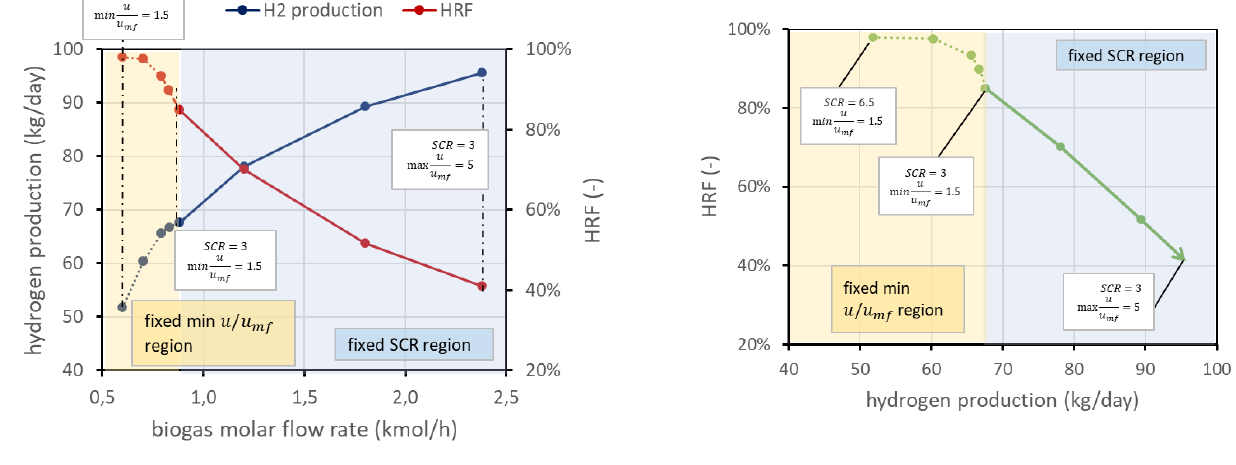
Figure 4. ( a ) Trends of HRF and hydrogen production for different BG flow rates in nominal conditions. ( b ) Performance chart corresponding to the same working points of ( a ). In both panels, the solid line represents the working points with fixed SCR and increasing velocity in the direction of the arrow. The dotted line is the region where velocity is fixed and then SCR has to increase to provide enough steam to fluidize the bed.